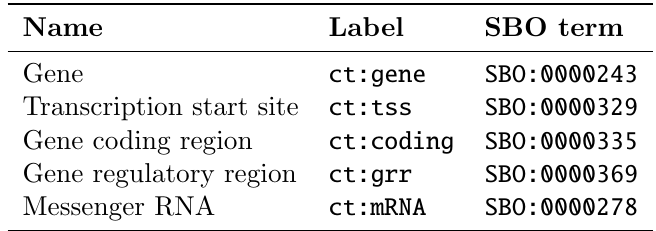
Table 2.3: A sample of values from the conceptual types vocabulary (Section 2.2.2).